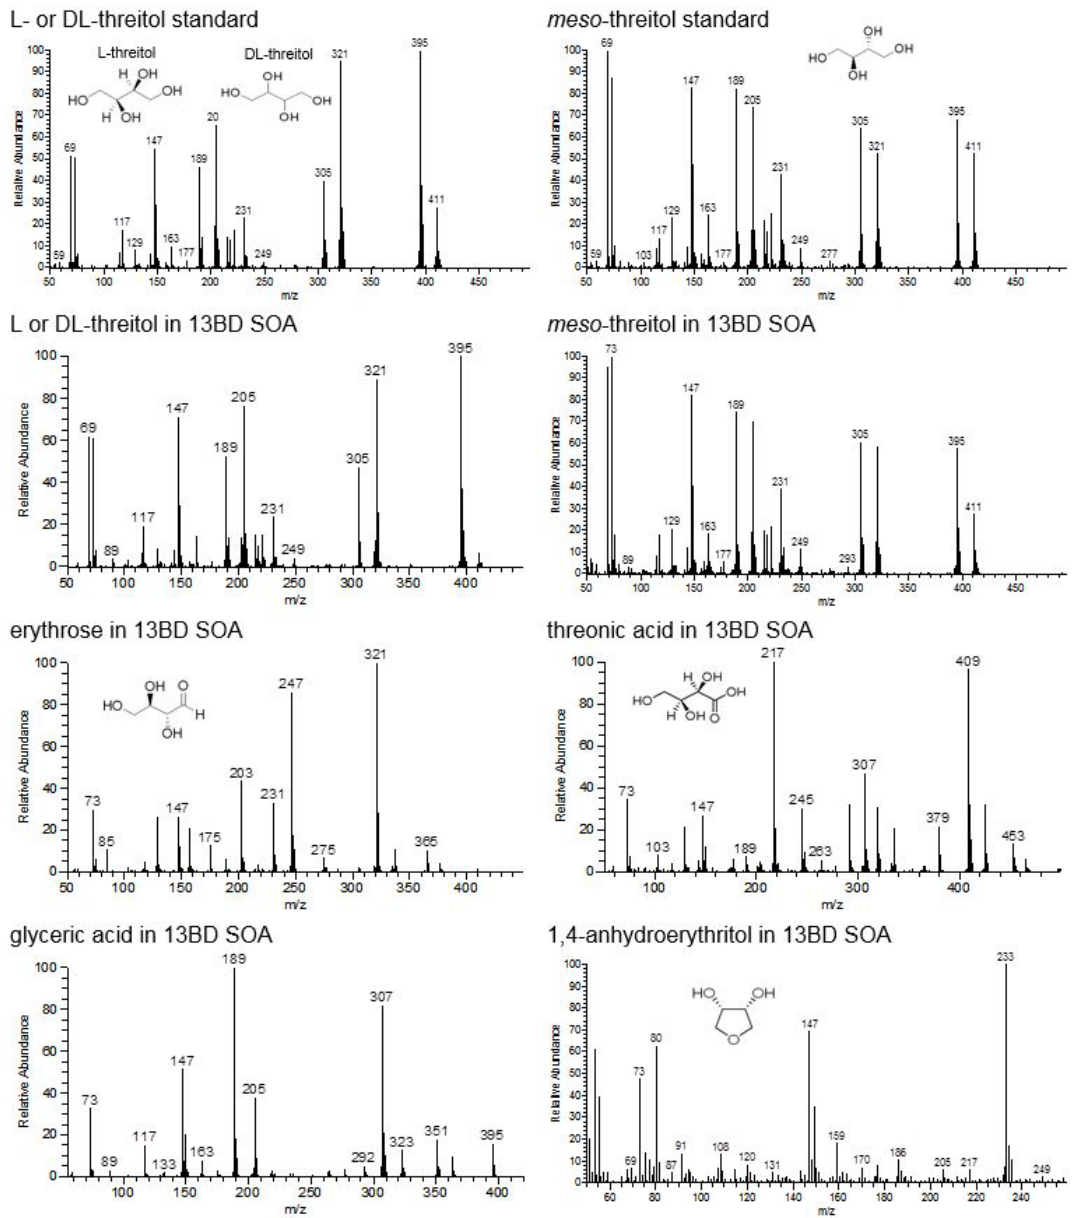
Figure 2. CI mass spectra of some organic compounds present in irradiated 1,3-butadiene/NO x